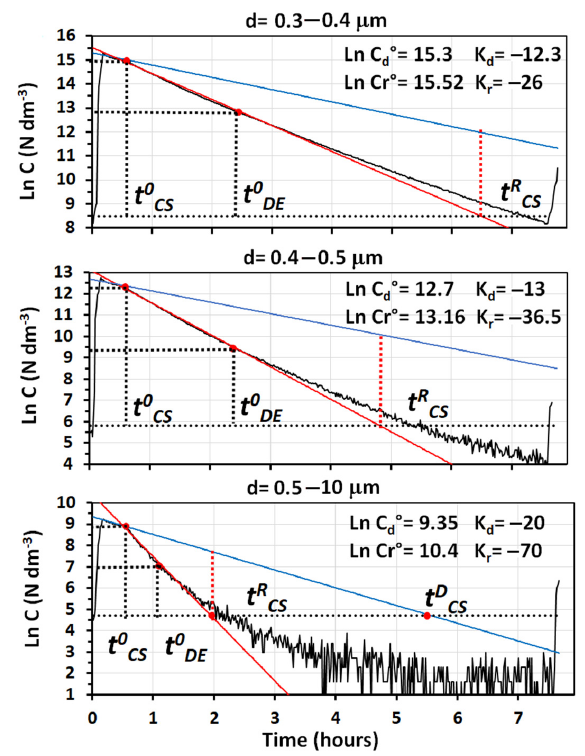
Figure 11. Semi-logarithmic plots of particle number concentration vs. time recorded in the testing room during an experiment performed with cigarette smoke emission (CS), using the SANINDOOR prototype as a cleaner. The meaning of solid lines is the same as that of the previous figures. Values of the slopes and intercepts determined for natural adsorption/deposition (subscript d ) and for cleaning (subscript r ) are also reported in the figure. They are referred to as the initial time, t INIT = 0, of the experiment. For the sake of comparison, the initial values of concentration that were obtained with diesel exhaust emissions are also reported. They are indicated in the figure by the subscript DE